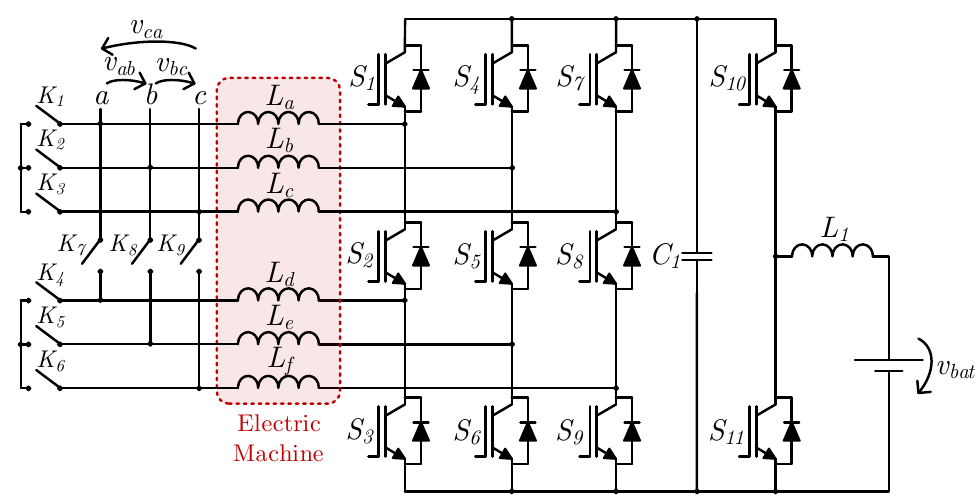
Figure 18. EV IBC proposed by M. Diab et al. in 2016 [37]. In 2016, I. Subotic et al. proposed an IBC based on a five-phase machine [38]. The same authors analyzed slow [39] and fast [40] battery charging operations using IBCs based on five-phase, six-phase and nine-phase electric machines. In the same year, the authors presented an IBC with galvanic isolation based on six-phase machines, where they simply added a three-phase transformer between the power grid and the converter [41]. It should be noted that these publications regarding multiphase machines only focus on the interface with the power grid (single-phase ac or three-phase ac) and do not consider a dc–dc converter for interfacing with the battery. In the following year, however, the same authors proposed two IBCs with direct interfacing with the power grid, including a bidirectional buck–boost dc–dc converter to interface with the battery. One of these systems is applied to six-phase machines and three-phase ac power grids [42], while the other is applied to nine-phase machines and can be connected to either single-phase or three-phase ac power grids [43]. Figure 19 shows the common structure between the proposed topologies from the power grid interface point of view, i.e., for five-phase (Figure 19a), six-phase (Figure 19b) and nine-phase (Figure 19c) electric machines. Regarding the five-phase topology, when it is connected to a single-phase ac power grid (terminals a , n ), one of the terminals contains two stator windings (in this case a ) and the other contains three stator windings (in this case n ). On the other hand, when connected to a three-phase ac power grid (terminals a , b , c ), two stator windings are used in two of the machine phases (in this case a , c ) and only one is used in the remaining phase (in this case b ). In the case of the six-phase topology, since the phase number is even and a multiple of three, the stator windings are equally divided in both types of interfaces and are assembled in pairs (in the case of a three-phase ac power grid) or in triplets (in the case of a single-phase ac power grid). Finally, for the nine-phase topology, the stator windings are grouped in triplets in both cases, using the three winding groups in the interface with a three-phase ac power grid and only two of them in the interface with a single-phase ac power grid.